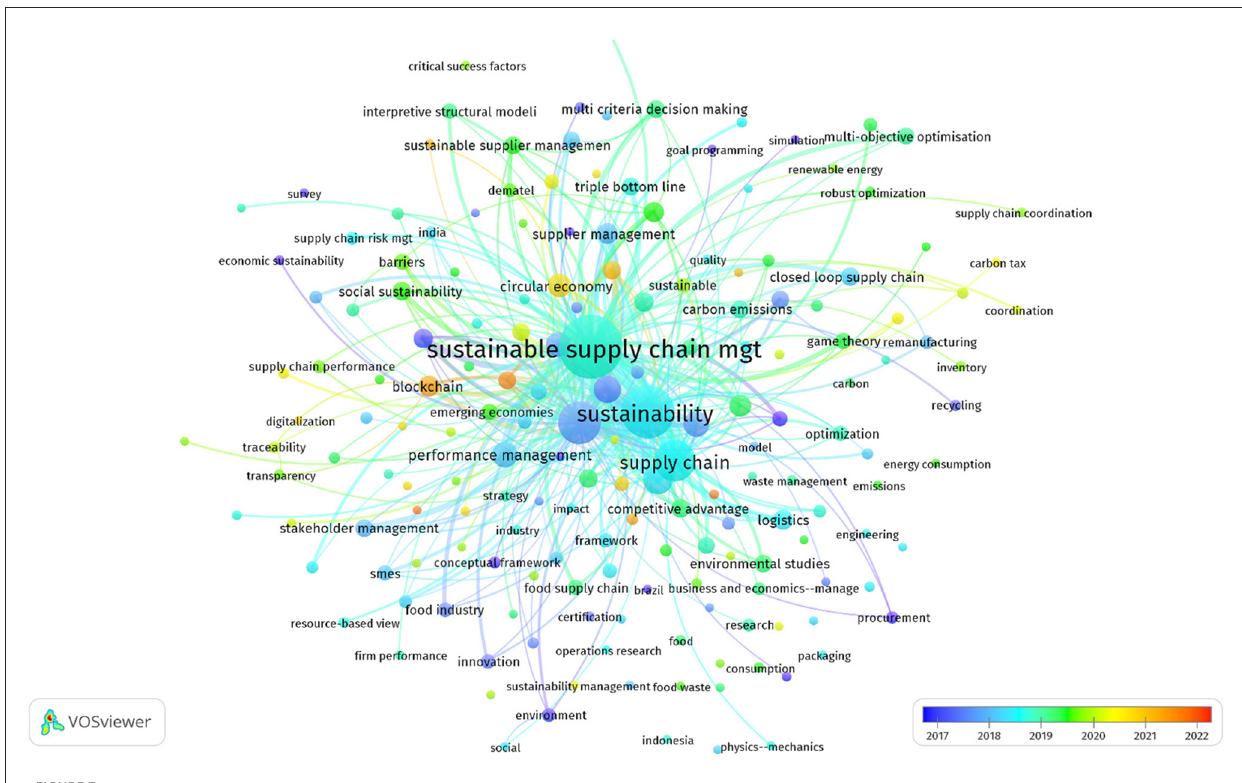
FIGURE7 Overlay visualization of top